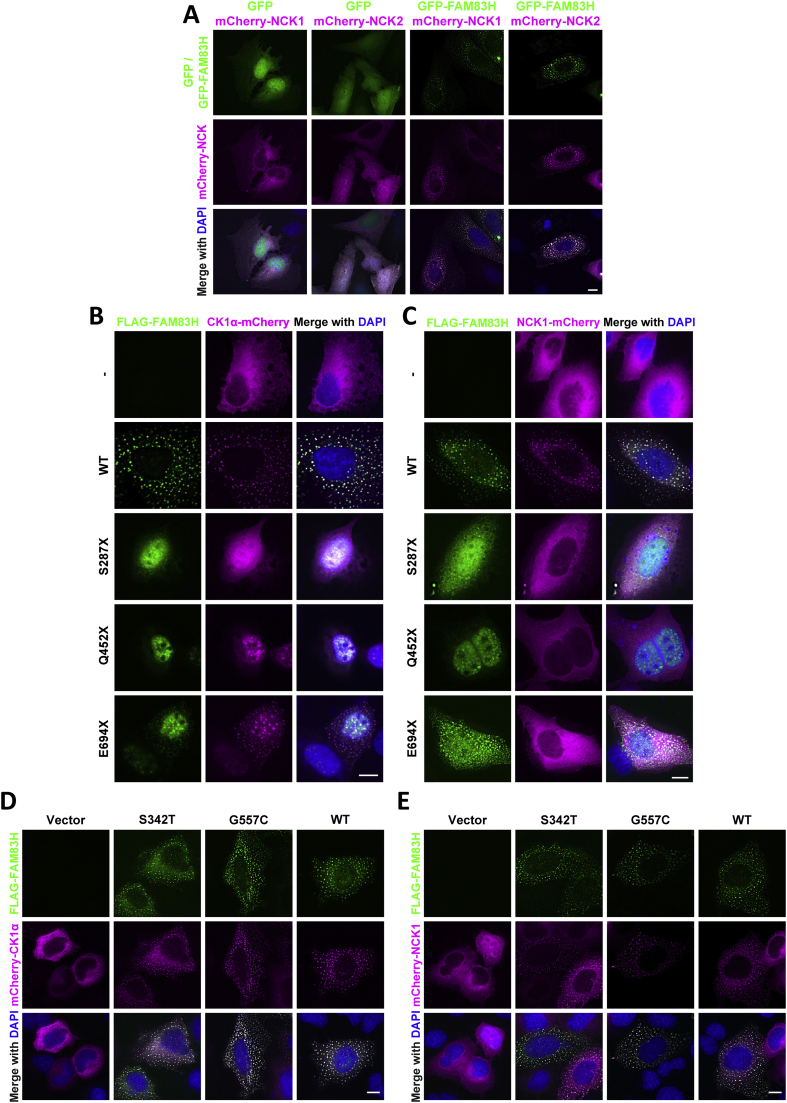
Wild type FAM83H and disease mutants co-localise with CK1, but mutants do not colocalise with NCK1.A U2OS FAM83H-/- cells transiently expressing GFP, GFP-FAM83H, mCherry-NCK1 or mCherry-NCK2, as indicated, were fixed and stained with 4′,6-diamidino-2-phenylindole (DAPI). Cells were imaged using the DeltaVision widefield fluorescence microscope then images were deconvolved and processed using OMERO (12). Scale bar represents 10 μm. n = 3B As A but U2OS FAM83H-/- cells were transiently transfected with FLAG-FAM83HWT (WT), FLAG-FAM83HS287X (S287X), FLAG-FAM83HQ452X (Q452X), FLAG-FAM83HE694X (E694X), or no FLAG construct (−) and co-transfected with mCherry-CK1α. Scale bar represents 10 μm. n = 3C As B but with mCherry-NCK1 instead of mCherry-CK1α. n = 2D U2OS FAM83H-/- cells transiently expressing FLAG (vector), FLAG-FAM83HS342T, FLAG-FAM83HG557C, FLAG-FAM83HWT and mCherry-CK1α were fixed and stained with anti-FLAG antibodies and DNA stained with DAPI. Cells were imaged using DeltaVision widefield fluorescence microscope. Scale bar represents 10 μm. n = 2E As D but mCherry-NCK1 was used instead of mCherry-CK1α. Scale bar represents 10 μm. n = 1